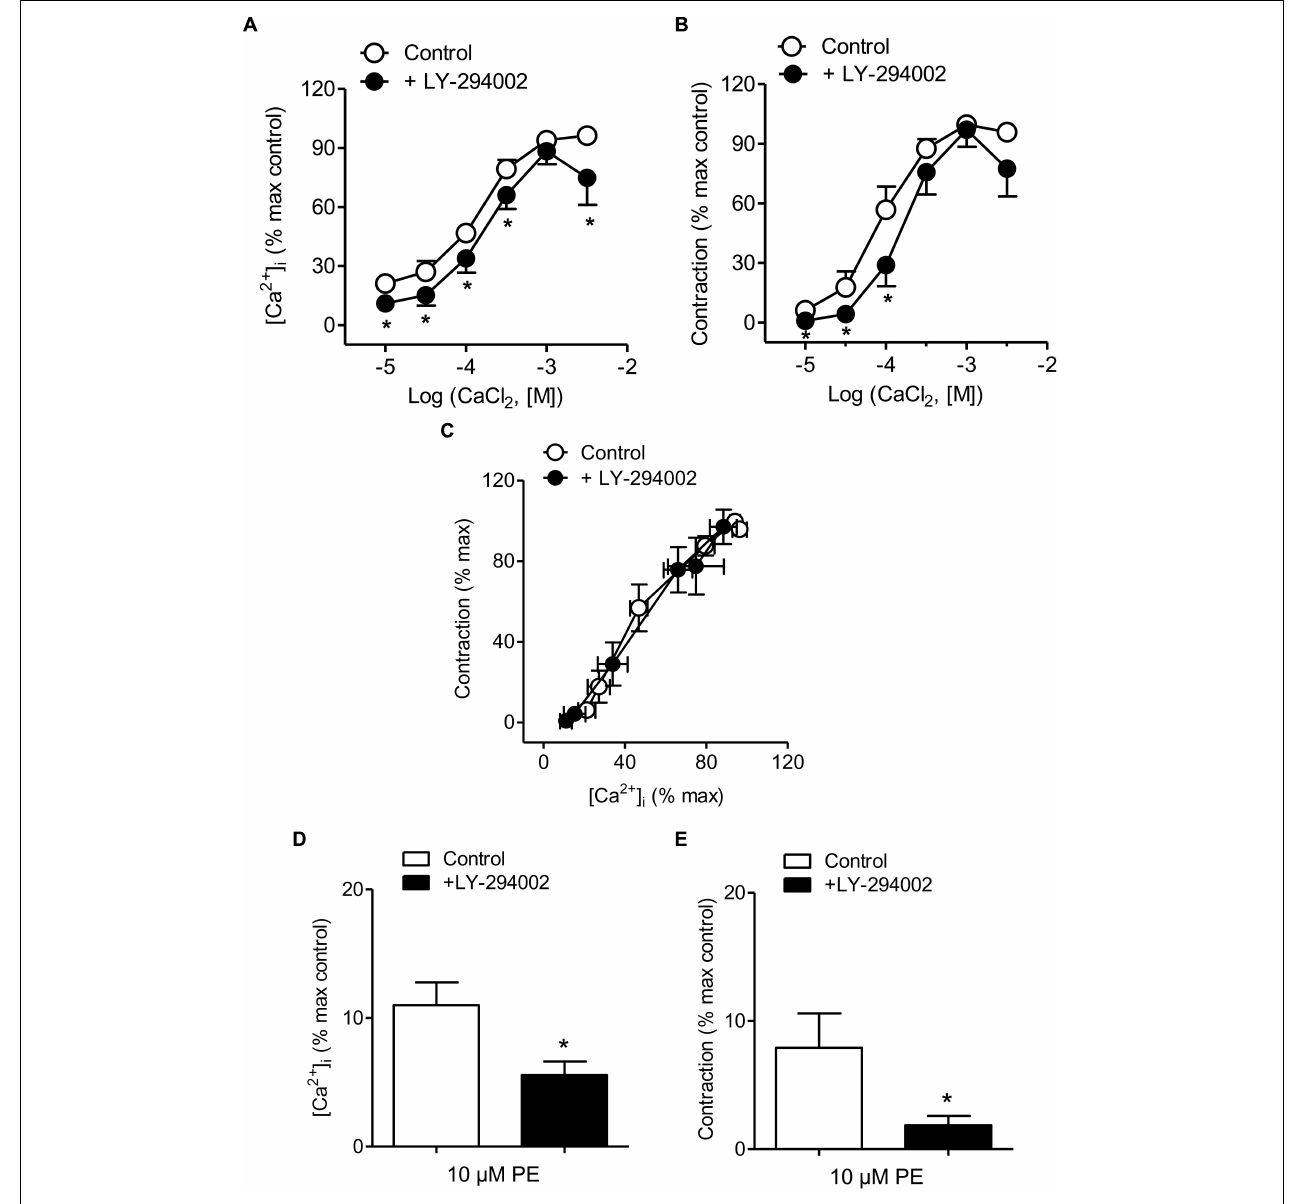
FIGURE 3 | PI3K inhibition reduced Ca 2 + entry, vasoconstriction and intracellular Ca 2 + mobilization in response to α 1 -adrenoceptor activation. (A,B) Summarized data showing the effects of the PI3K inhibitor LY-294002 (3 µ M) on the increases in [Ca 2 + ] i (A) and contraction (B) elicited by cumulative addition of CaCl 2 in endothelium-denuded arteries kept in a nominally Ca 2 + -free medium and stimulated by 10 µ M PE. (C) Effect of LY-294002 on the [Ca 2 + ] i -contraction relationship for 10 µ M PE in mesenteric resistance arteries and (D,E) the increases in [Ca 2 + ] i and contraction elicited by 10 µ M PE in nominally Ca 2 + -free PSS. Results are expressed as a percentage of control maximal responses. Values are means ± SEM of n = 8 arteries (one from each animal). ∗ P < 0.05 vs.